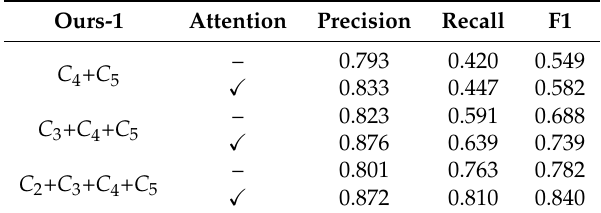
Table 5. Detection results when fusing different layers.